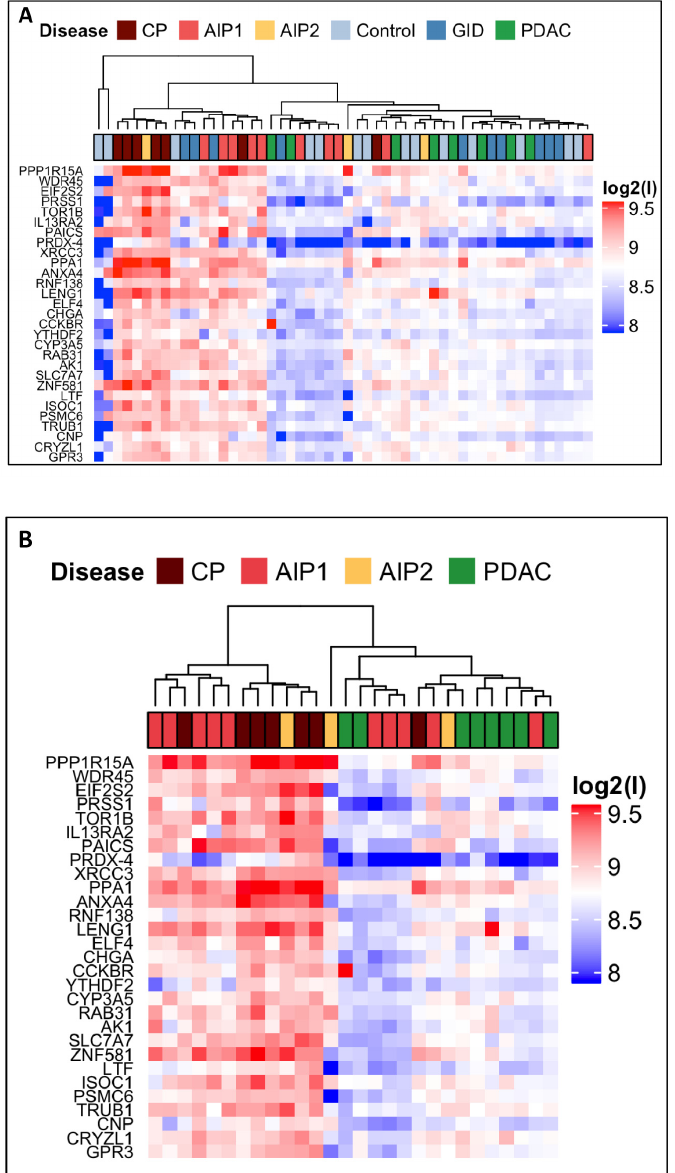
Figure 2. Overview of pooled serum antibody reactivity to the selected autoantigens. AIP-1, AIP-2 and CP mostly show higher autoantibody reactivity than PDAC and, thus, help to di ff erentiate PDAC from primarily inflammatory pancreatic diseases. Heatmaps generated from intermediate-sized protein microarrays data presenting serum antibodies reactivity with the indicated antigens in the six tested cohorts. High autoantibody reactivity values are presented by red, low autoantibody reactivity by blue boxes. Data are presented as di ff erential median fluorescence intensity MFI (MFI log2 scale) levels of the response to the 29 autoantigens. ( A ) For comparison of all cohorts the following pools were used: Co ( n = 14); PDAC ( n = 8); CP ( n = 7); GID ( n = 10); AIP-1 ( n = 10), and AIP-2 ( n = 3). ( B ) Hierarchical clustering using the log2 MFI of the 29 autoantigens between the three di ff erent pancreatic diseases and visualization of higher reactivity of CP- and both AIP subtypes-serum antibodies versus PDAC-serum